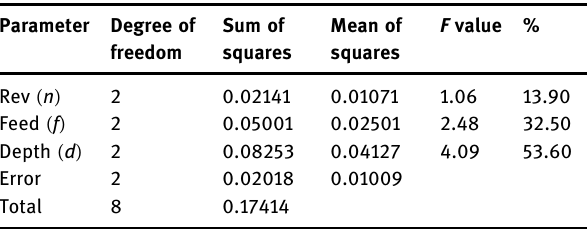
Table 7: Surface roughness ANOVA results 1 mm tool Parameter Degree